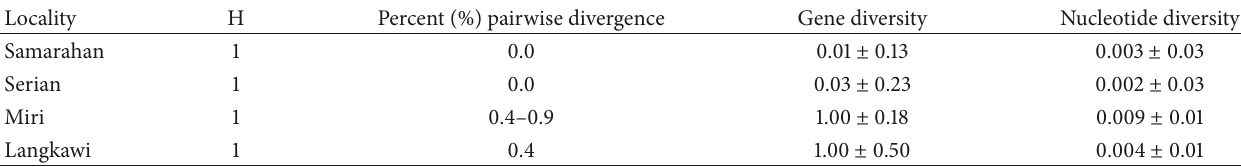
Table 4: Measures of haplotypes and nucleotide diversity within populations of T. schlegelii analyzed by location. Locality H